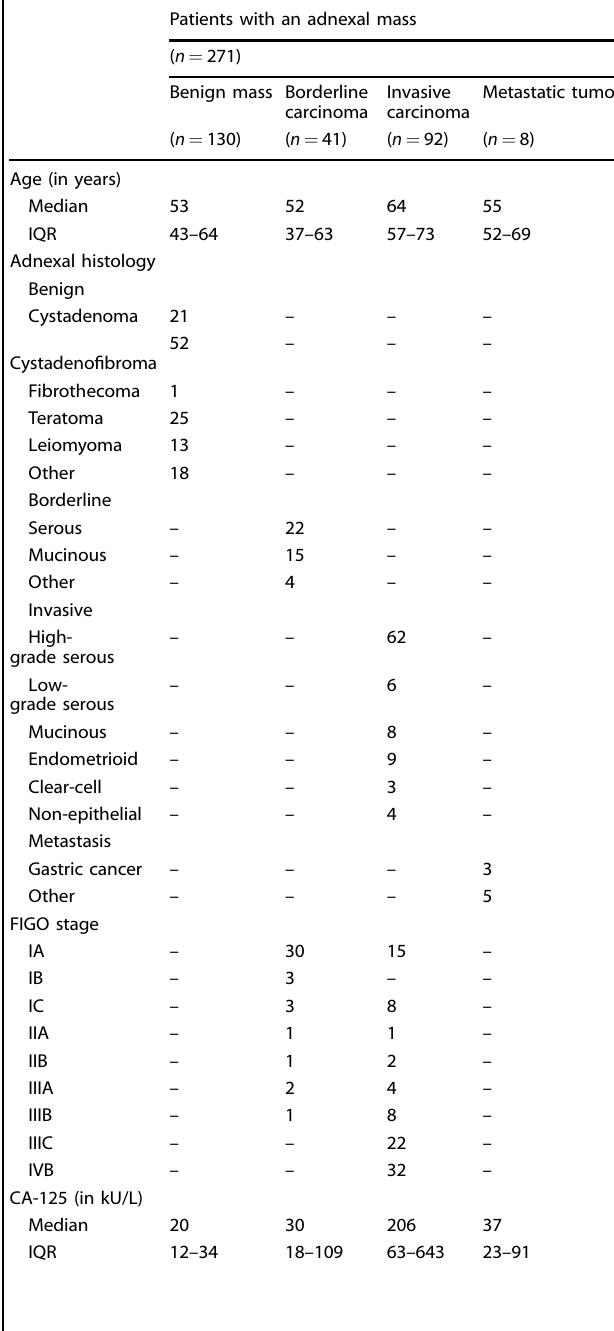
Table 1. Clinical characteristics of the 271 patients with adnexal